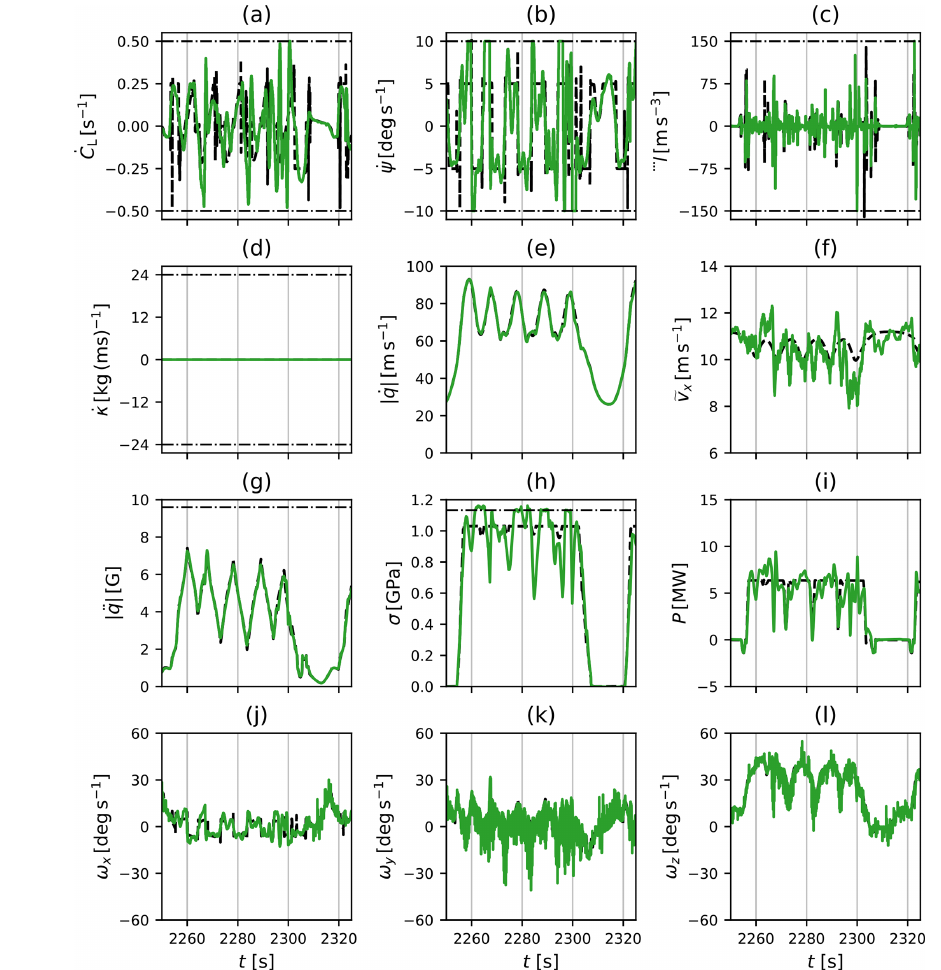
Figure B6. Instantaneous controls and additional quantities measured at the point mass of the lift-mode AWE system 003 (park L1) compared to their reference values. The control variables, i.e. the time derivatives of lift coefficient ˙ C L , roll angle ˙ (cid:57) , and thrust coefficient ˙ κ , and the ... l are shown in (a–d) . The magnitude of the flight speed |˙ q | and the streamwise wind speed (cid:101) v x are shown in (e) and (f) . The tether jerk magnitude of acceleration |¨ q | , the tether stress σ , and the instantaneous power P are respectively shown in (h, i) . The components of the angular velocity ω are shown in (j–l) . The black dashed and dashed–dotted lines respectively represent the variable references and the eventual constraints applied to the variables in NMPC (Eq.